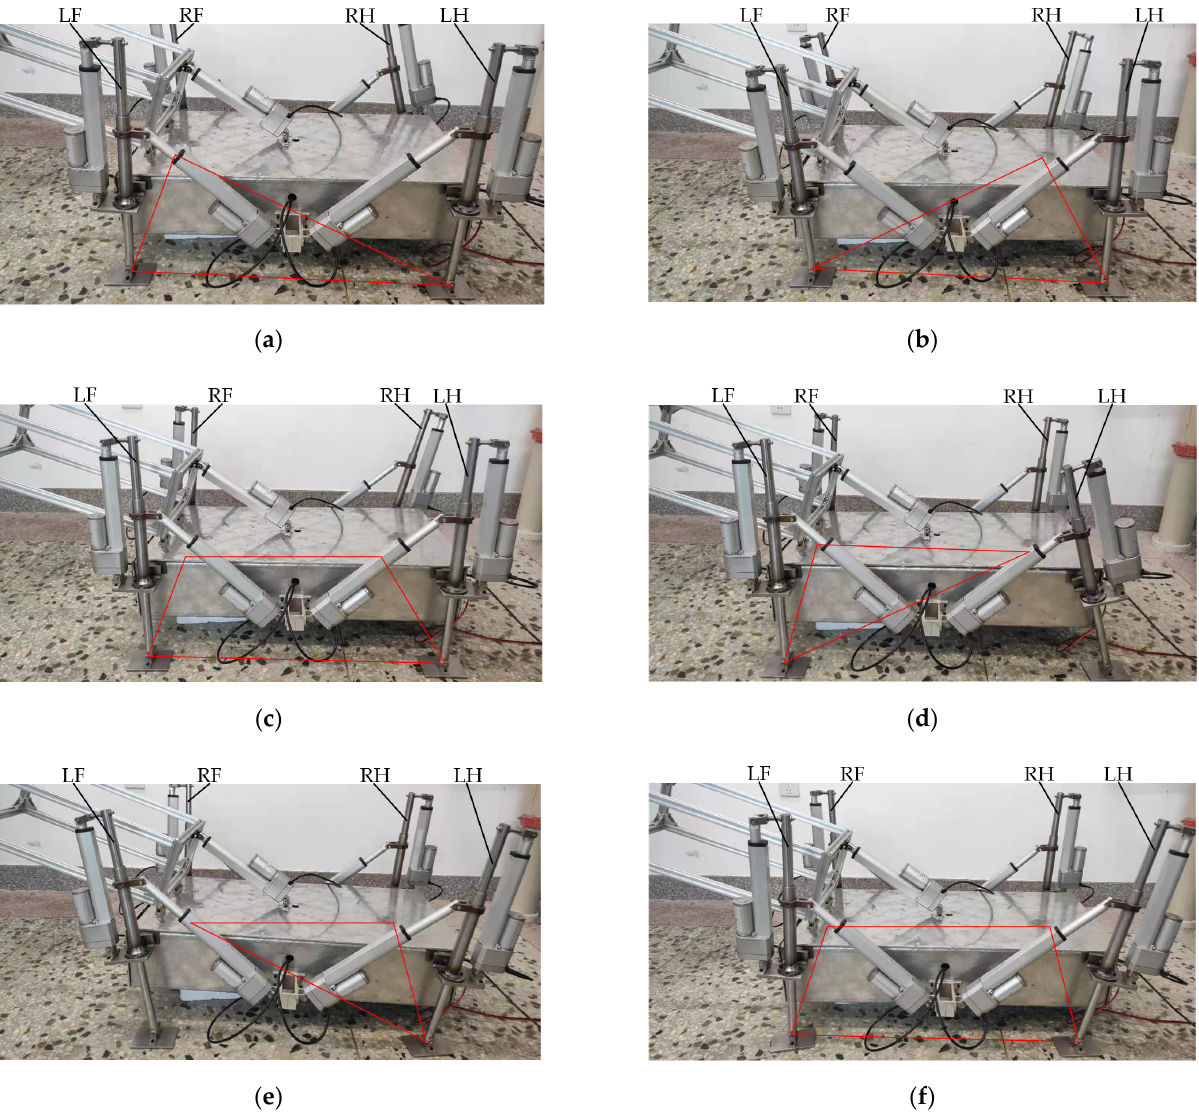
Figure 17. The motion state of the experimental prototype in a cycle in the intermittent gait: ( a ) the RH is about to lift, ( b ) the RF is about to lift, ( c ) adjust the center of gravity for the first time, ( d ) the LH is about to lift, ( e ) the LF is about to lift, and ( f ) adjust the center of gravity for the second time.